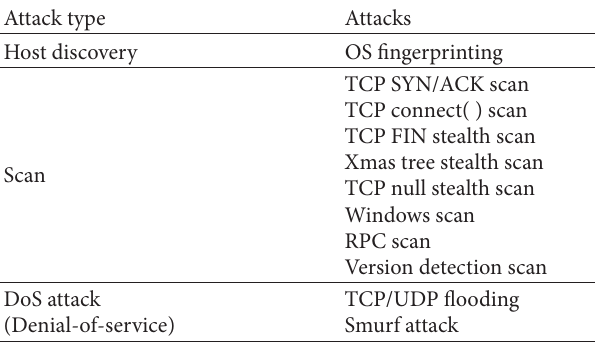
Table 1: Network protocol